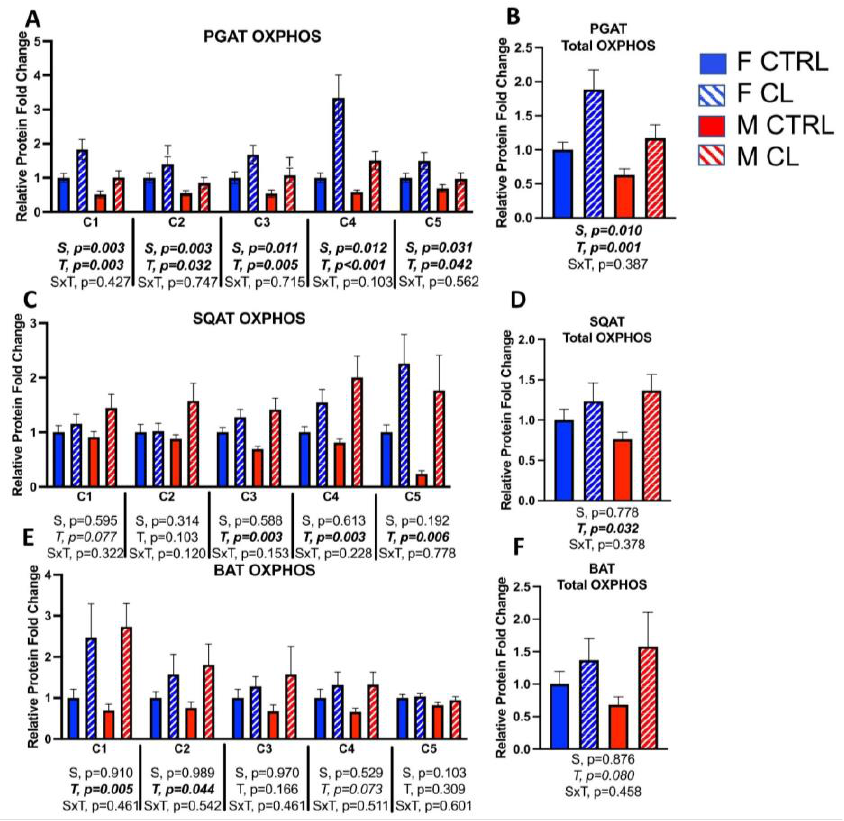
Figure 5. Male (M) and female (F) C57BL/6J mice, all on HFD, were treated for 2 weeks with daily CL injections (1 μg/g body weight) or CTRL (saline). Perigonadal (PGAT), subcutaneous (SQAT) and brown (BAT) adipose tissue depots were collected and the expressions of all five oxidative phosphorylation protein complexes (OXPHOS) were measured via western blot. Complex 1, NADH dehydrogenase (C1). Complex 2, Succinate dehydrogenase (C2). Complex 3, Ubiquinol Cytochrome c oxidoreductase (C3). Complex 4, Cytochrome c oxidoreductase (C4). Complex 5, ATP Synthase. Total OX PHOS represents the summation of bands C1-5. ( A ) PGAT C1-C5; ( B ) PGAT Total OXPHOS; ( C ) SQAT C1-C5; ( D ) SQAT Total OXPHOS; ( E ) BAT C1-C5; ( F ) BAT Total OXPHOS. Blot intensity relative to beta actin was calculated. All data are presented as mean ± SEM, relative to the F CTRL. N = 7–9/group. Main effects of sex (S), CL treatment (T) and sex by treatment interactions (S × T) were determined by 2 × 2 ANOVA, and are presented below the respective figures. p -value < 0.05 accepted as